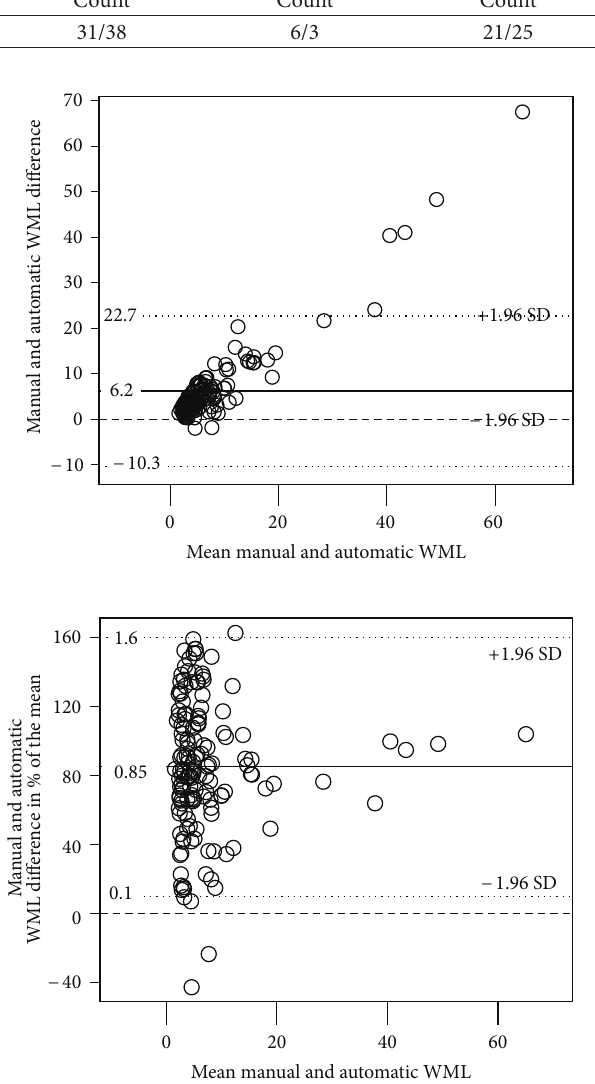
-axis contains absolute differences in (a) and fractional differences of mean volume in (b). e 𝑦𝑦